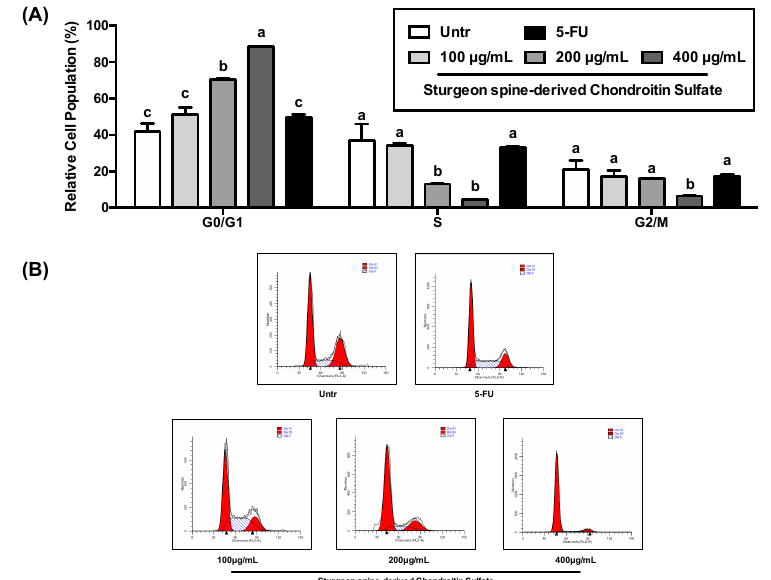
Figure 2. Effect of SCS on cell cycle arrest in colon cancer HCT-116 cells. Colon cancer HCT-116 cells were treated with different concentration (100, 200, and 400 μ g/mL) of SCS (spine) and 5-FU (100 μ g/mL) for 24 h. The percentages of cells in each phase (G0/G1, S, G2/M) were calculated by cell cycle assay kit and flow cytometer. ( A ) Relative cell population in each phase, ( B ) Representation flow cytometer images. All results are expressed as mean ± SEM ( n = 3). Di ff erent superscript letters for each column indicate significant di ff erences ( p < 0.05) as compared to every other